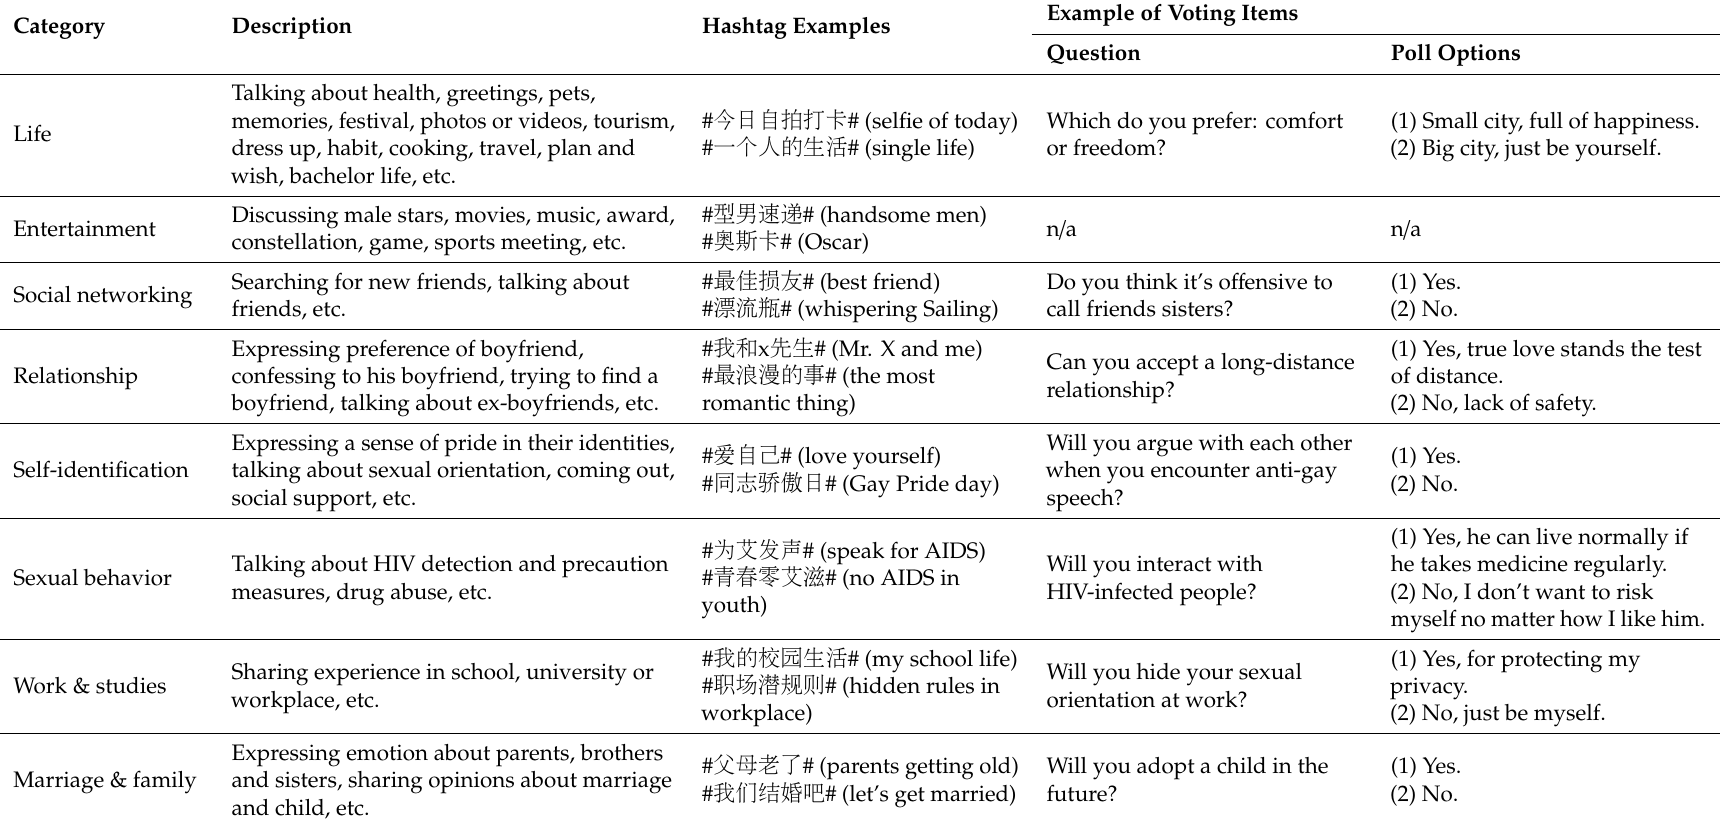
Table 1. Descriptions and examples of topic hashtag